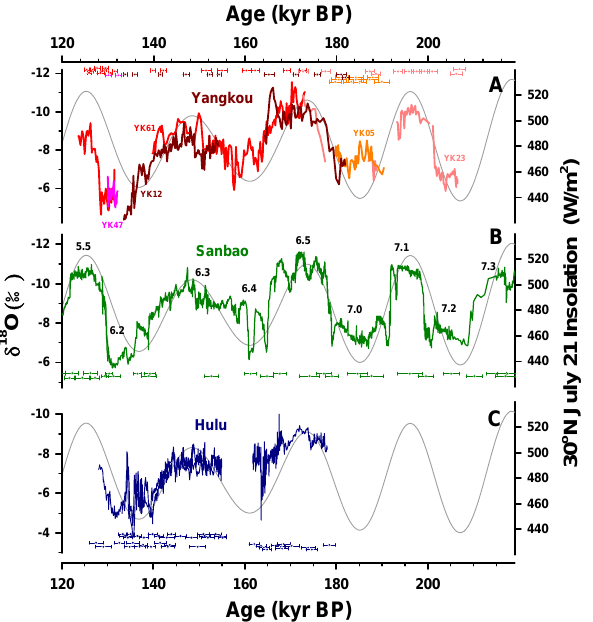
Figure 5. Cave stalagmite oxygen isotope records of (A) Yangkou (this study), (B) Sanbao (Wang et al., 2008; Cheng et al., 2009), and (C) Hulu (Cheng et al., 2006). U-Th ages and 2 σ errors were color- coded by stalagmite. Numbers of MIS 5.5–7.3 are given by Sanbao record. Gray line is NHSI on 21 July at 30 ◦ N.